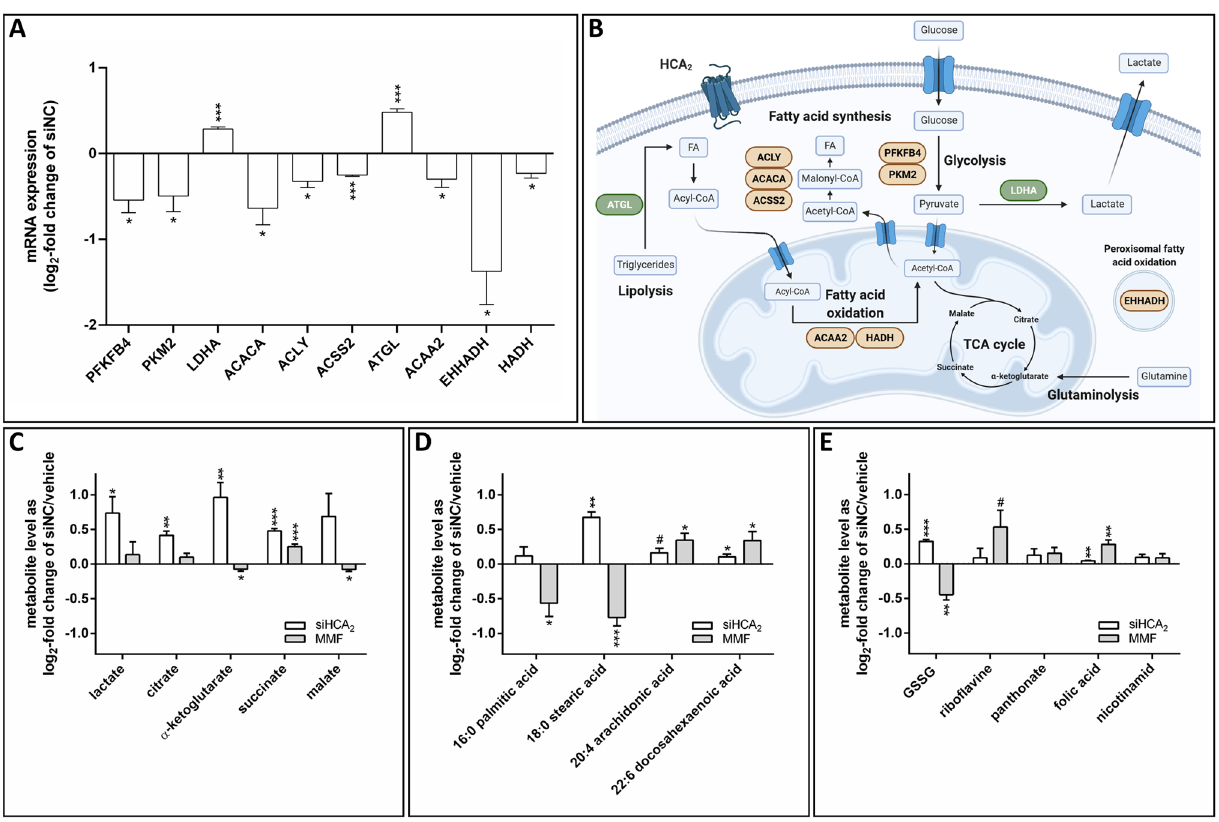
Fig. 4 Knockdown of HCA induced changes in the expression of metabolic enzymes and the metabolite profile of BT-474 cells. 48 h after 2 BT-474 cells were transfected with siNC or siRNAs targeting HCA (siHCA ), the mRNA expression of metabolic enzymes ( A , B ) was deter- 2 2 mined by RT-qPCR experiments, and the metabolite levels ( C–E ) were measured using LC-MS. Additionally, untransfected BT-474 cells were stimulated with 200 µM monomethyl fumarate (MMF) before LC-MS analysis. A Knockdown of HCA caused changes in the mRNA expres- 2 sion of metabolic enzymes involved in glycolysis, lipolysis, fatty acid oxidation and synthesis. B Main metabolic pathways used for energy generation and macromolecule synthesis with changes in the mRNA expression of key metabolic enzymes caused by knockdown of HCA 2 (green: increased expression; red: decreased expression). C–E siRNA mediated knockdown (siHCA ) or stimulation of HCA with MMF led 2 2 to changes in the levels of glycolysis and TCA cycle metabolites ( C ), fatty acids ( D ), oxidized glutathione (GSSG) and vitamins ( E ). Data are shown as mean ± SEM of n = 3 independent experiments. Statistical analyses were performed using an unpaired t-test. # P ≤ 0.1; *P ≤ 0.05; **P ≤ 0.01; ***P ≤